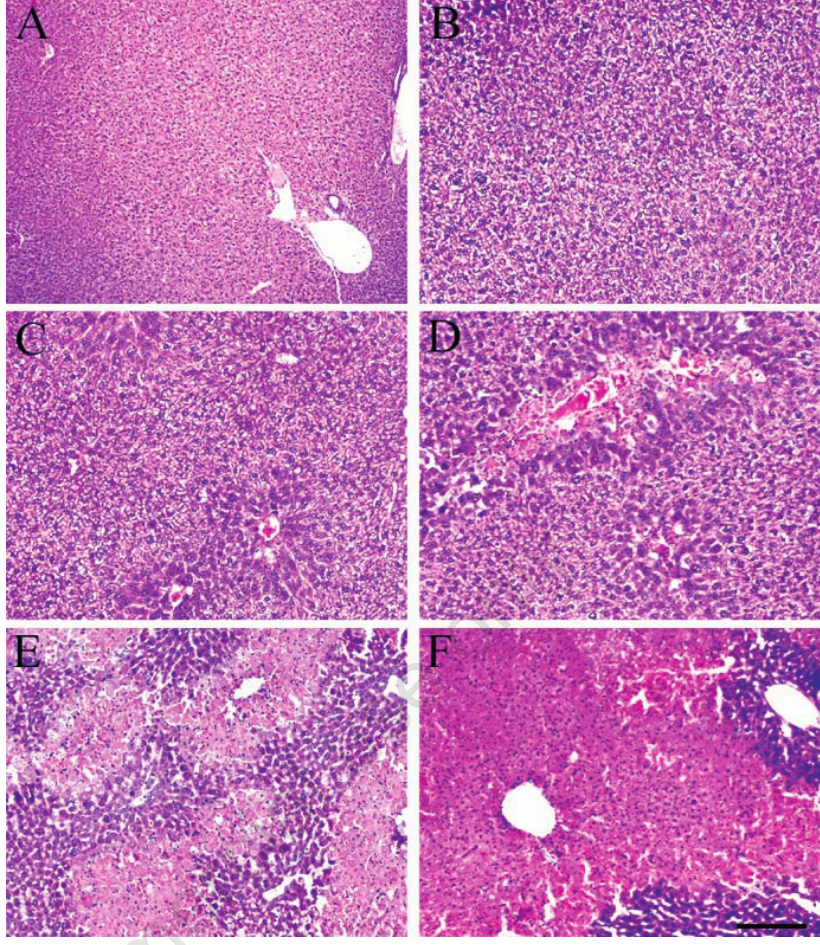
Figure 5. Histopathological changes in livers from normal and APAP-intoxicated mice. Livers were collected 20-22 h after APAP administration (150 mg/kg). Graduation of liver damage was determined according to the arbitrary scale as follows: degree 0 (A), degree 1 (B), degree 2 (C), degree 3 (D), degree 4 (E) and degree 5 (F). Descriptions of each degree are explained in Materials and Methods. Sections were stained with hematoxyllin and eosin (original magnification, ¥